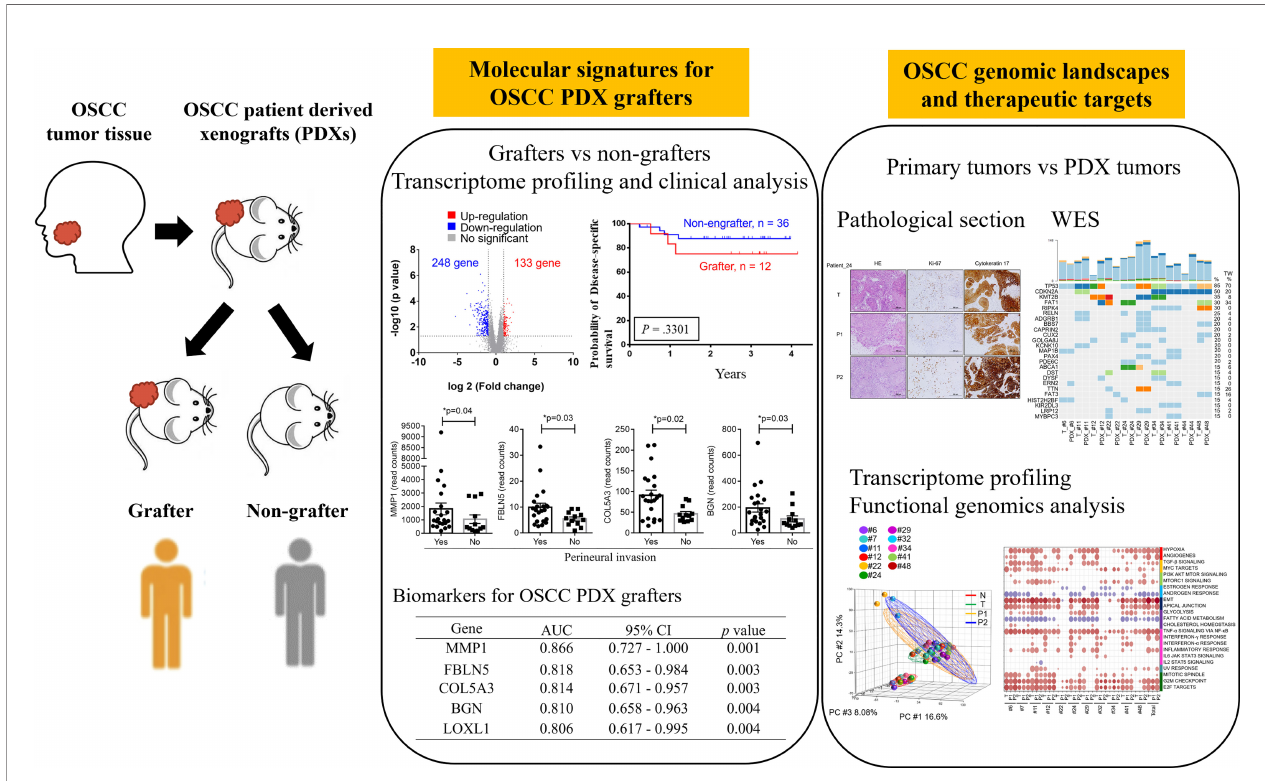
FIGURE 1 | Work fl ow for the establishment and characterization of OSCC PDX models. Overall, 49 OSCC patients were enrolled in this study. Of the 49 tumors, 12 were successfully engrafted in NSG mice as PDX passage 1 (P1) and PDX passage 2 (P2). The specimens were subjected to pathology analysis, whole-exome sequencing, and RNA-seq. Finally, genomic landscape analysis and gene expression pathway annotation were performed to characterize the molecular signatures in patients and their matched